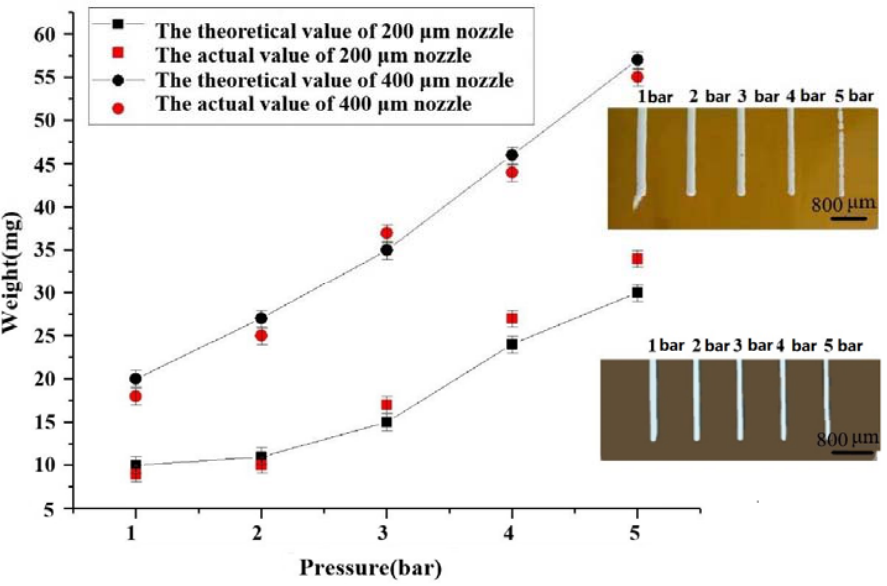
Figure 8. Variation of extruded material mass at different air pressures for two nozzle diameters.